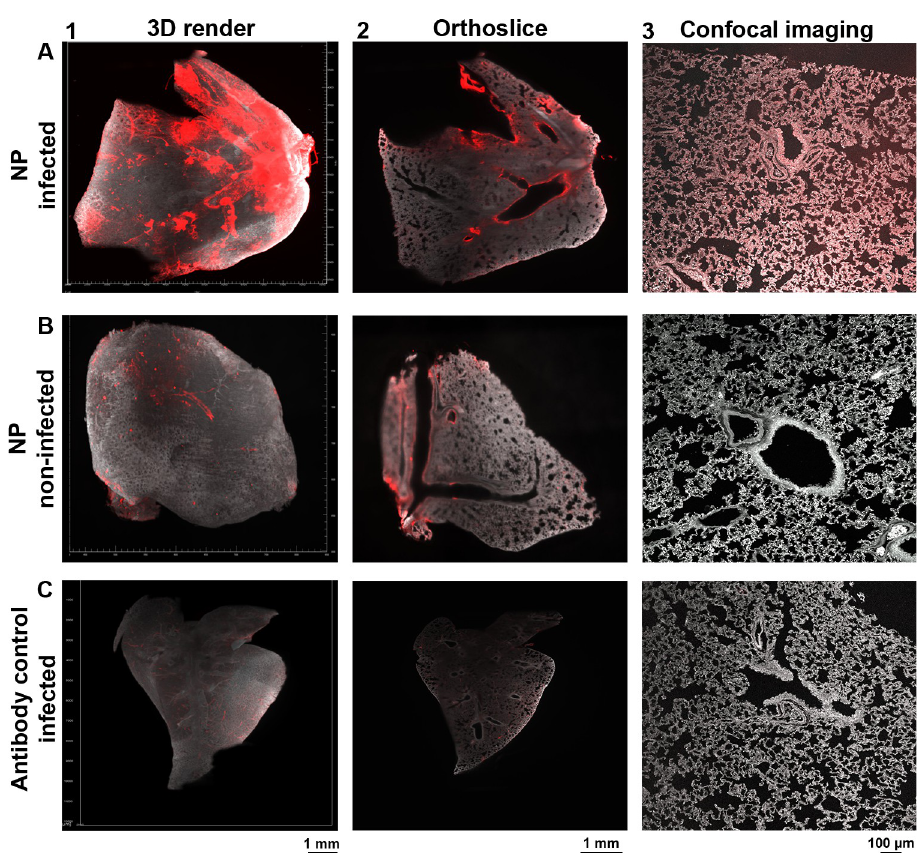
Fig 3. Detecting infected cells within a whole Syrian hamster lung lobe. Autofluorescence in grey (488 channel) and staining in red (647 channel). (A) Significant NP staining in the primary/secondary bronchi and bronchioles, with occasional tertiary bronchi and alveolar staining (light-sheet and confocal imaging data). (B) Non-specific binding in non-infected when using the anti-NP antibody in the bronchi and outer regions of the lung, although with a lower apparent signal intensity relative to infected lungs (light-sheet and confocal imaging data). (C) Minor autofluorescence and a-specific staining with secondary antibodies, the observed pattern does not overlap with previous stains (light- sheet and confocal imaging